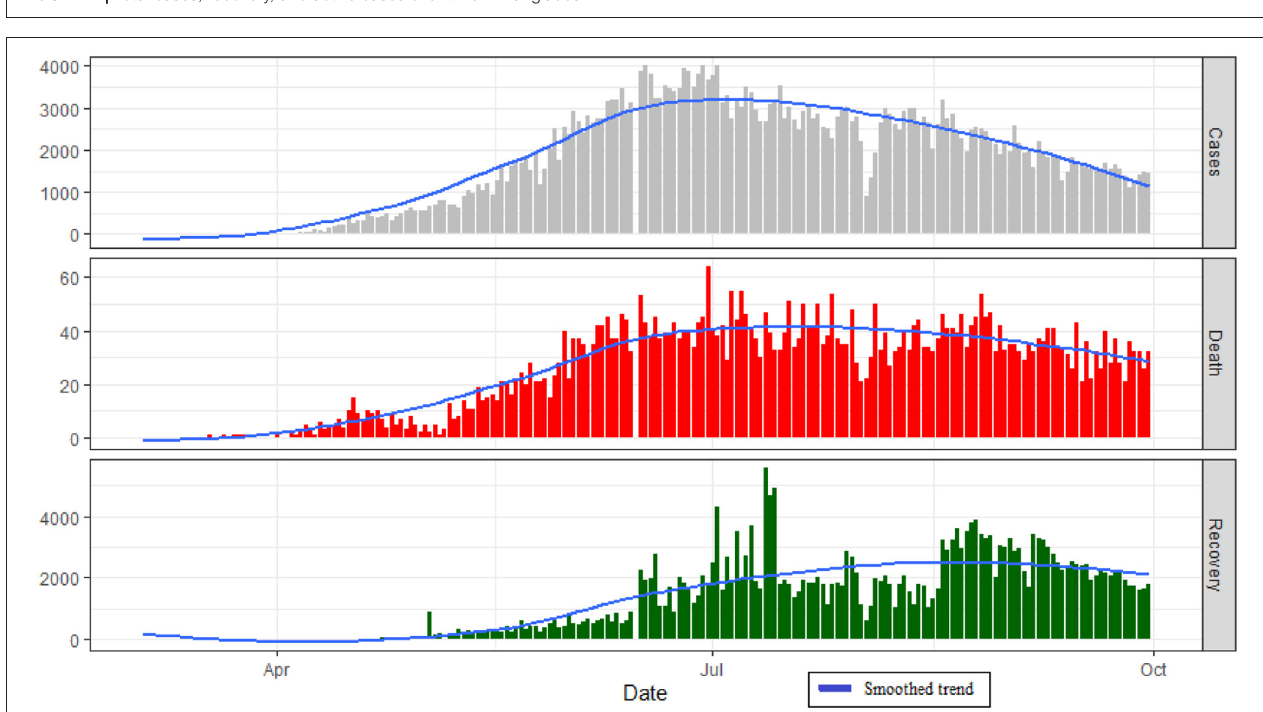
FIGURE 3 | Daily change in cases, recovery, and death in